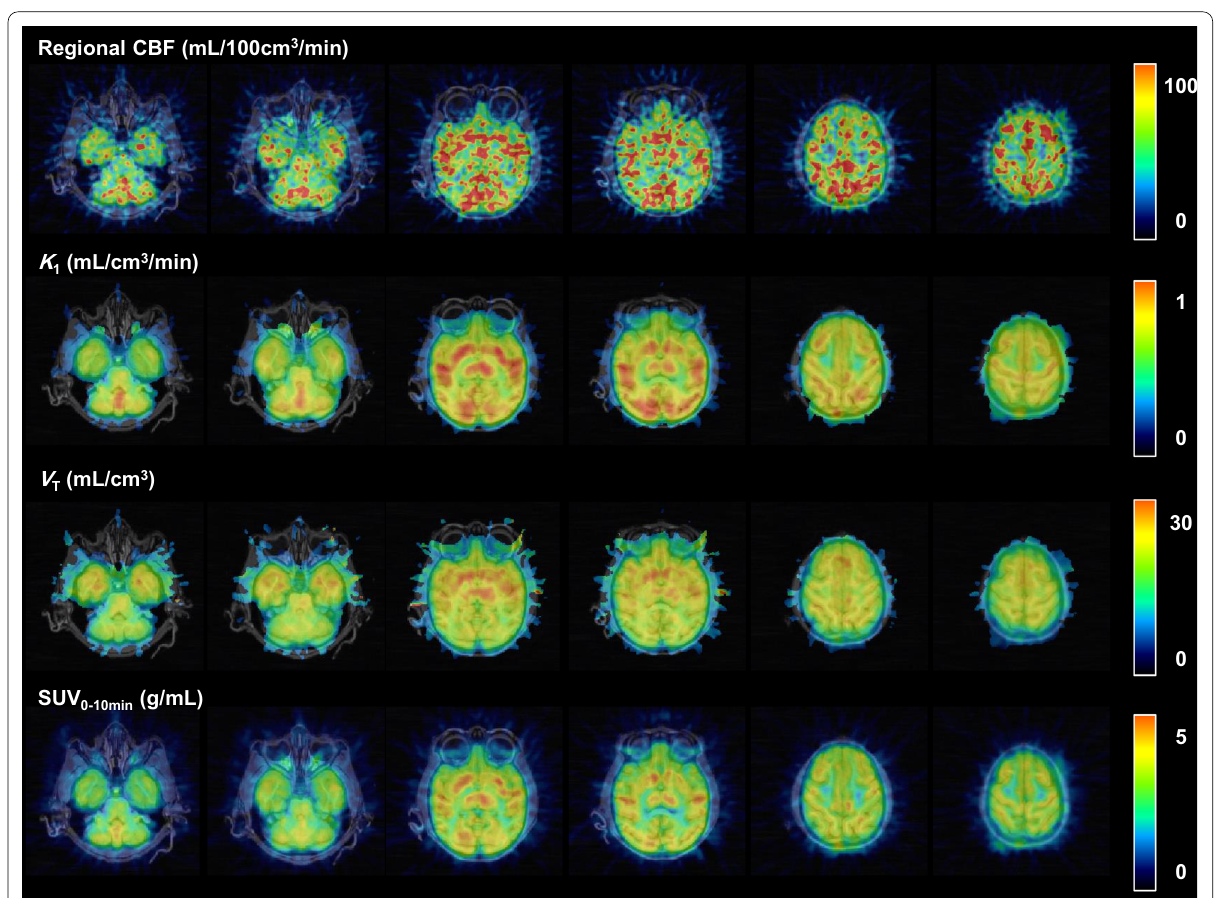
Fig. 6 MR-fused parametric images of the vehicle-pretreated monkey. Regional CBF images of [ 15 O]H 2 O were calculated using autoradiography [28, 29]. Parametric images of [ 11 C] 4 were calculated using a 45-min scan duration and one-tissue compartment model [30]. Static images acquired from 0 to 10 min after injection of [ 11 C] 4 were expressed as the